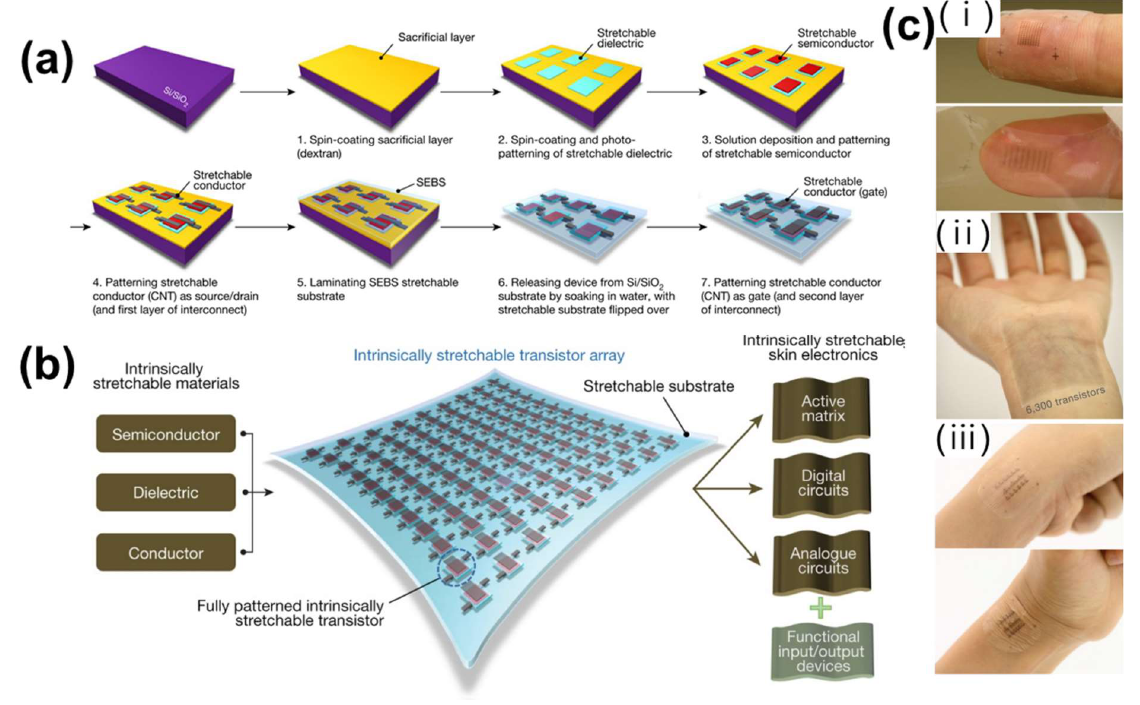
Figure 4. Schematics of transistor sensor array. ( a ) Fabrication process. ( b ) Three-dimensional diagram of an intrinsically stretchable transistor array. ( c ) A photo of the sensor attached to human skin [86]. Copyright © 2021, Macmillan Publishers Limited, part of Springer Nature. All rights reserved.